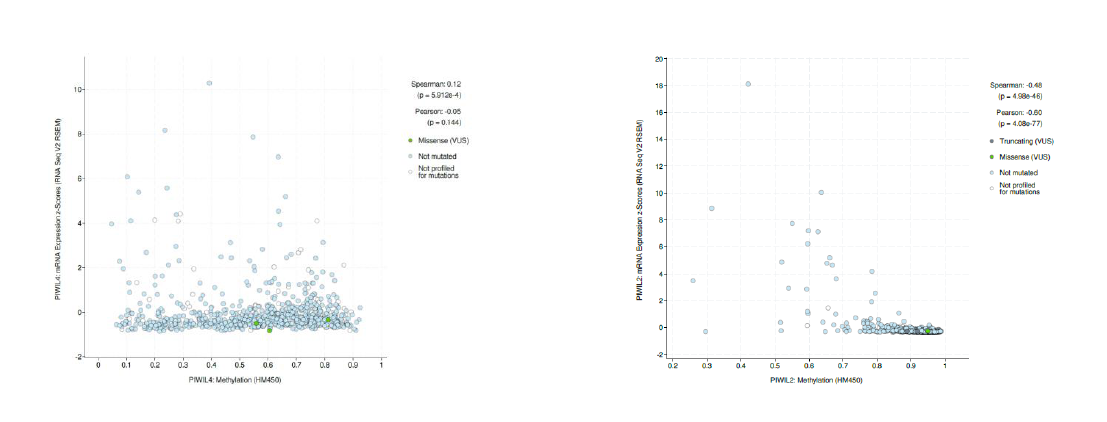
Figure 3. In silico and IHC analysis suggests that mechanisms of PIWIL2-4 underexpression are located at epigenetic or post-transcriptional levels. At magnification ×